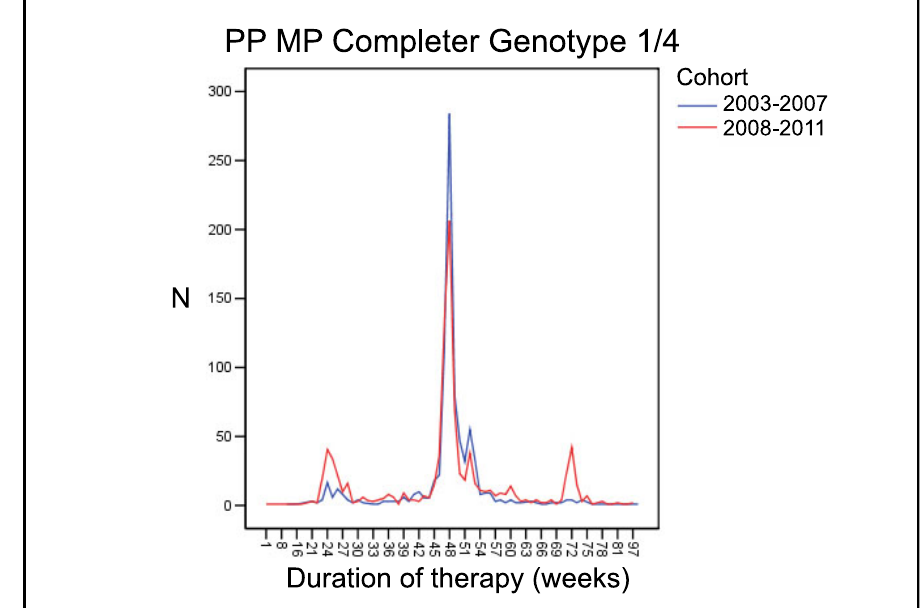
Fig 2. Comparison of treatment duration in patients infected with genotype 1/4 between 2003 – 2007 and 2008 – 2011 period. MP, matched pairs; PP, per protocol.